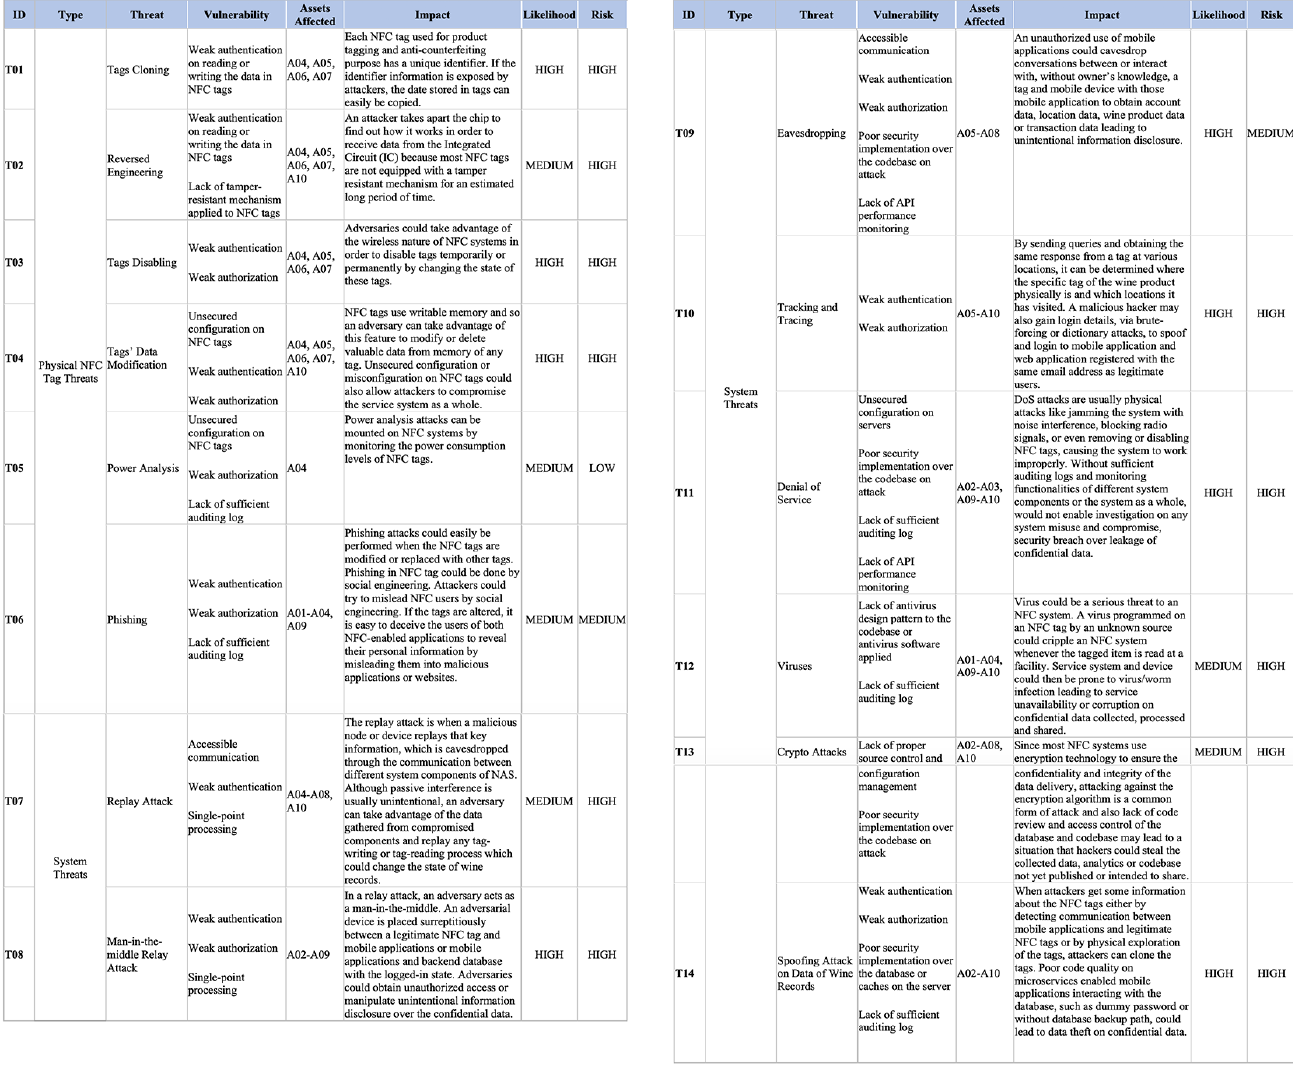
Figure A4. Threat analysis of